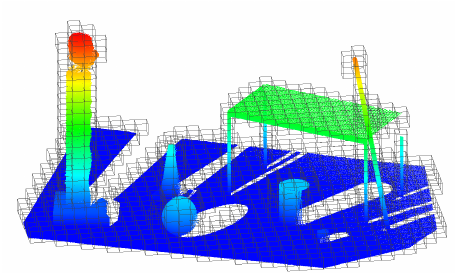
Figure 10: Refined clustering results of connected cells of the same geometric dimensionality